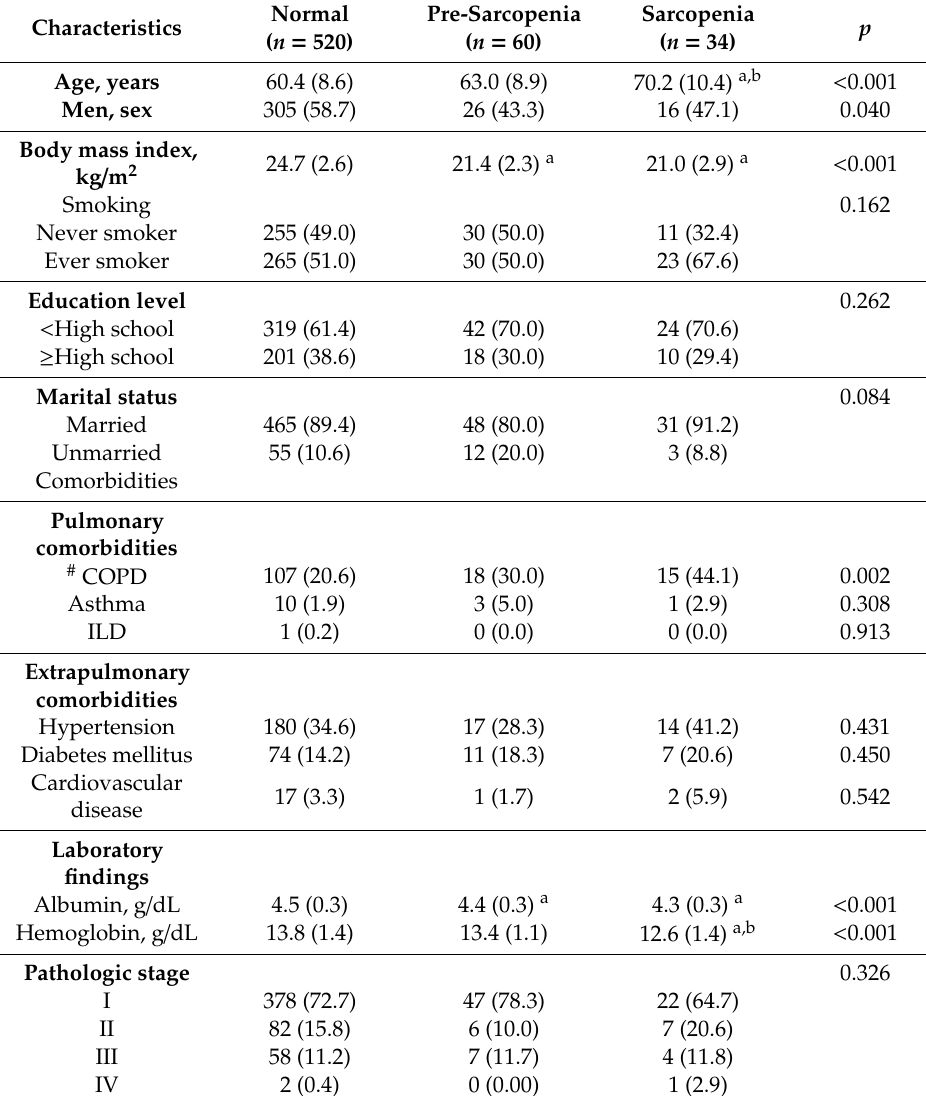
Table 1. Characteristics of study participants by sarcopenia group ( n =